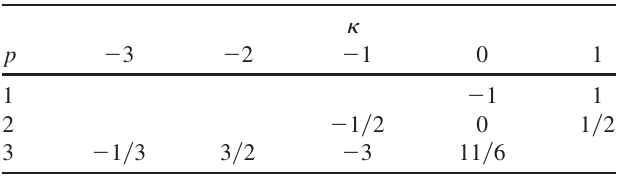
TABLE V. Coefficients h difference operator in z